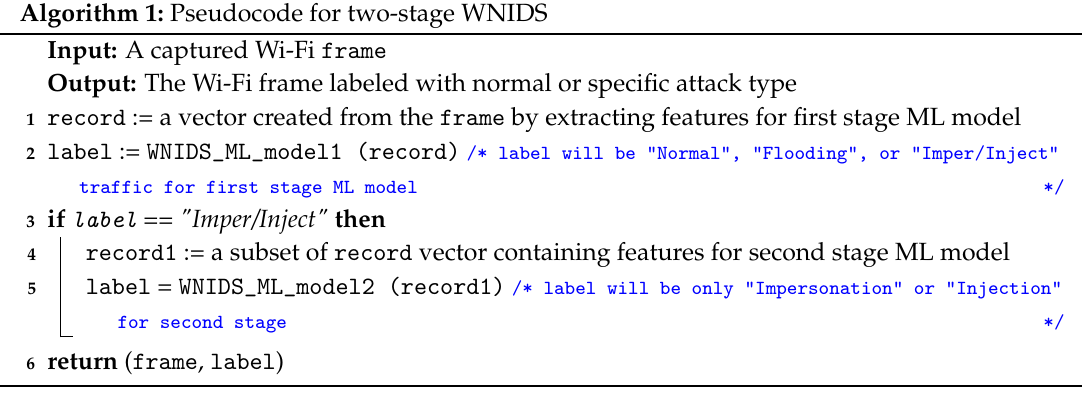
Algorithm 1: Pseudocode for two-stage